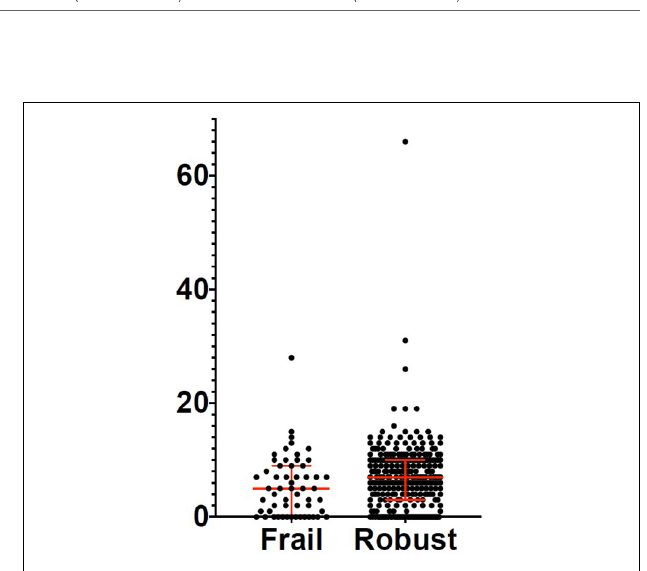
FIGURE 7 | Interval between symptoms onset and ED admission in frail and robust